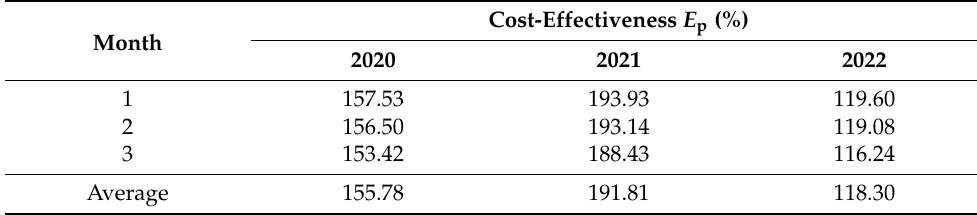
Table 16. Results of producing semi-finished furniture elements according to the variant “Bp”.